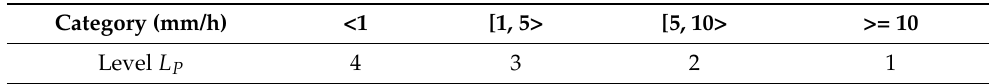
Table 6. Precipitation categories.